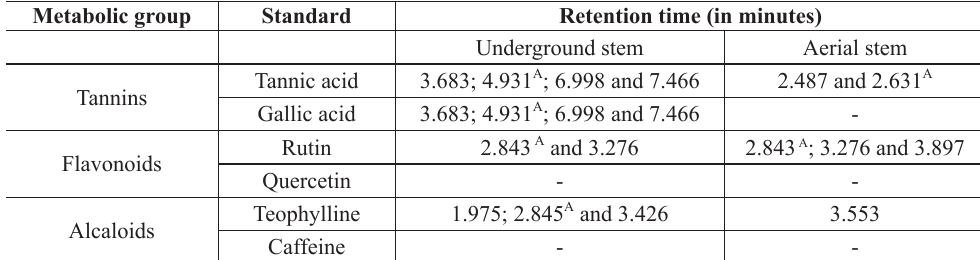
Results of the high-performance liquid chromatography (HPLC) in the underground and aerial stem of T. micrantha .